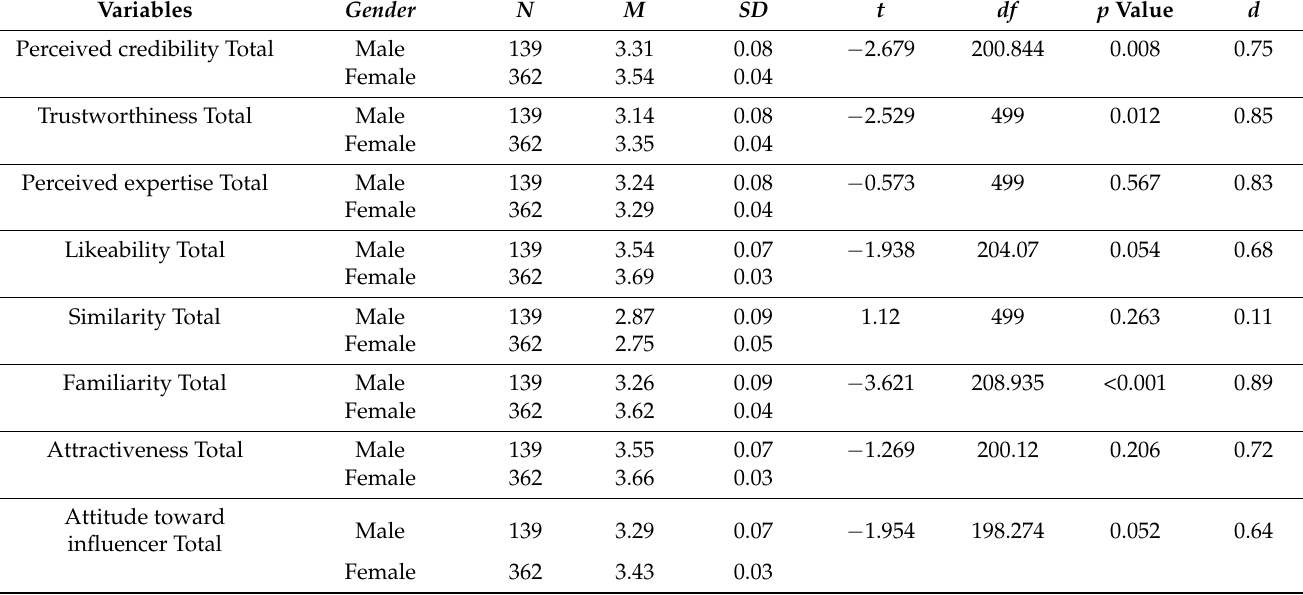
Table 3. Differences by